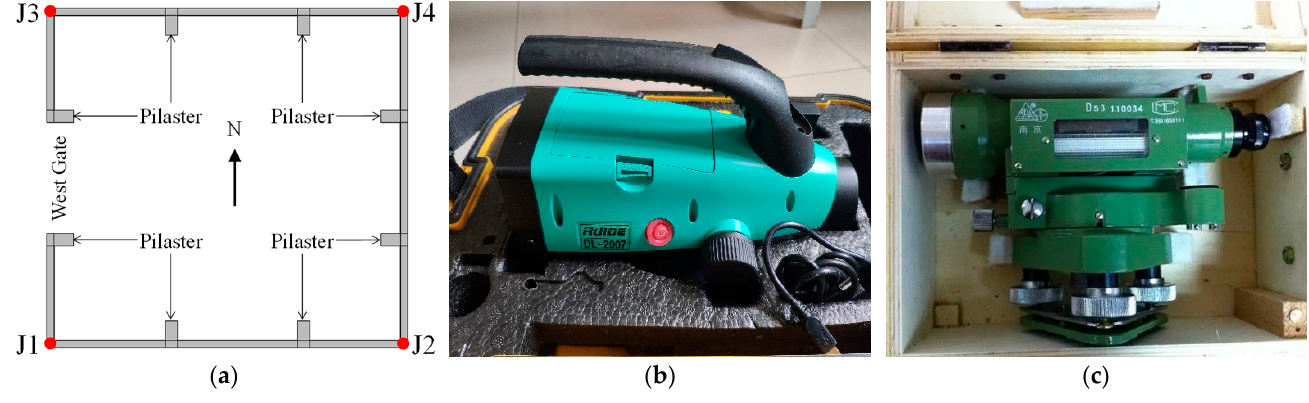
Figure 3. Layout of monitoring points and measuring instruments. ( a ) Layout of monitoring points; ( b ) DL-2007; ( c ) DS-3.